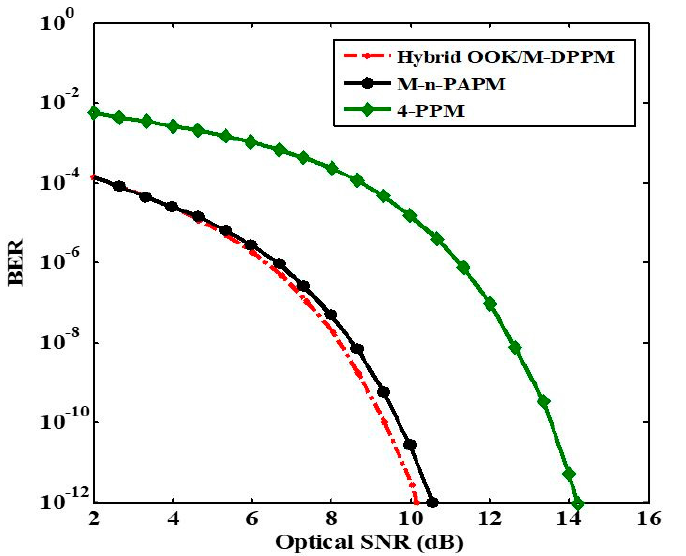
Figure 8. Optical signal-to-noise ratio (OSNR) to BER performance for the hybrid OOK/M-ary DPPM and M-n-PAPM modulation scheme.